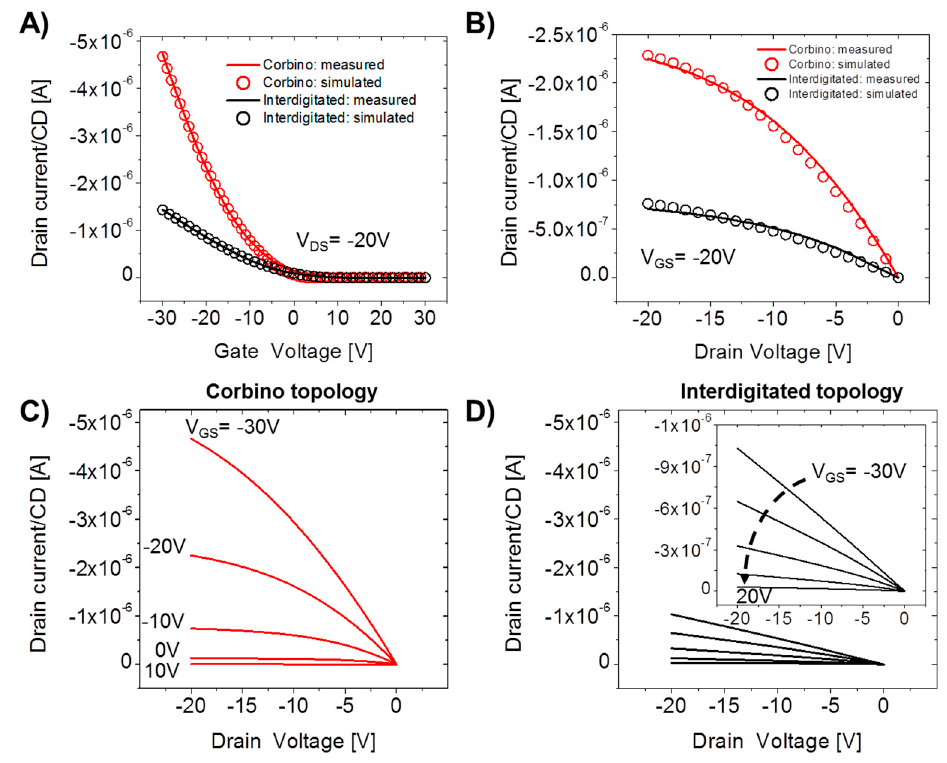
Figure 2. Experimental transfer ( A ) and output ( B ) characteristics for Corbino and interdigitated geometries normalized to Channel Dimension (CD) for V DS = − 20 V and V GS = − 20 V, respectively. The circular symbol refers to the theoretical transfer and output characteristics simulated by using a MOSFET level 3. ( C ) Experimental output characteristics of Corbino geometry devices. ( D ) Experimental output characteristics of interdigitated geometry devices where gate voltage (V GS ) were swept by − 10 V from − 30 V to 20 V. The output graph for interdigitated geometry is rescaled in the inset graph for better comparison. The channel length is 4 µm and 20 µm for interdigitated and the Corbino devices, respectively. Both have almost the same W/L ratio.